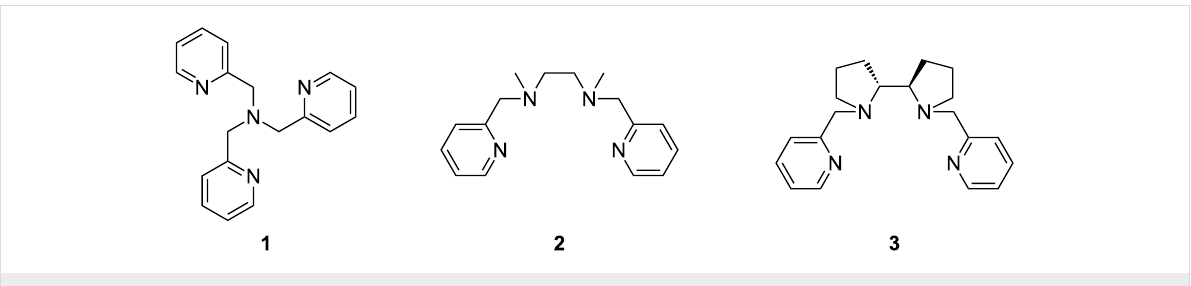
Figure 1: TPA ( 1 ), BPMEN ( 2 ) and ( R , R ′ )-PDP ( 3 ) ligands.